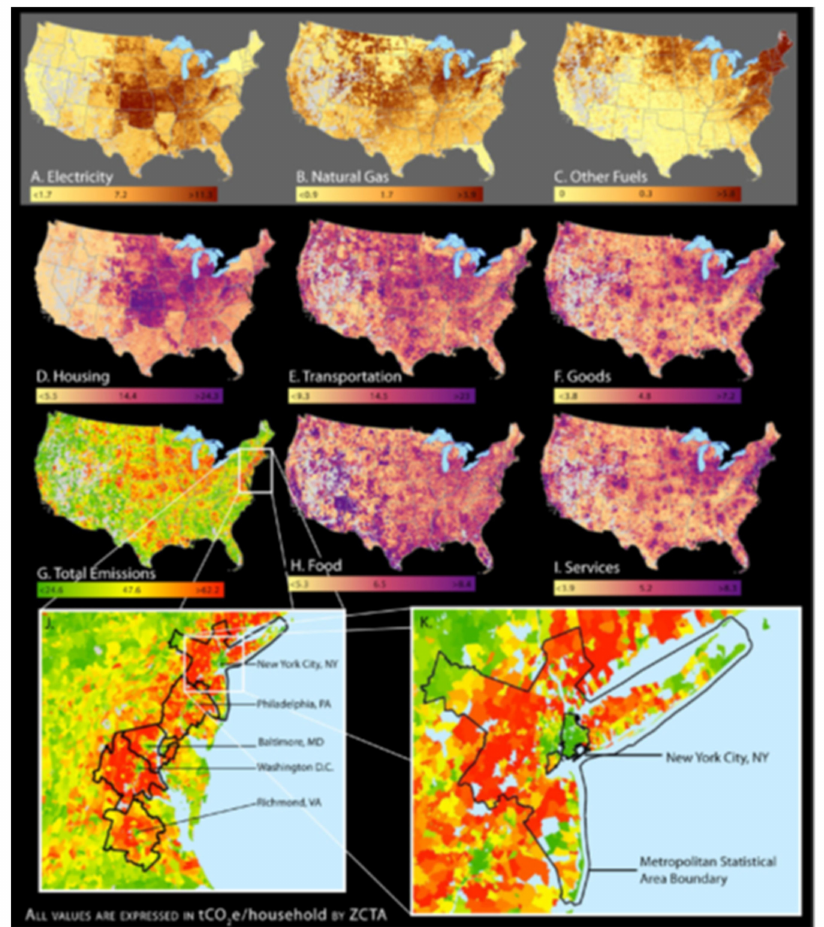
Figure 17. HCF from ( A ) electricity, ( B ) natural gas, ( C ) fuel oil and other fuels, ( D ) housing = A + B + C + water, waste, and home construction, ( E ) transportation, ( F ) goods, ( H ) food, ( I ) services, and ( G ) total = D + E + F + H + I. Transportation includes motor vehicle fuel, lifecycle emissions from fuel, motor vehicle manufacturing, air travel direct and indirect emissions, and public transit. Scales below each map show gradients of 30 colours, with labels for the upper value of lowest of quantile, median value and lowest value of highest quantile, in metric tons CO2e per household, for zip code tabulation areas (ZCTAs). East Coast metropolitan statistical areas ( J ), with a larger map of New York metropolitan area ( K , outer line) and New York City ( K , inner line), highlight the consistent pattern of relatively low GHG urban core cities and high GHG suburbs. Source: